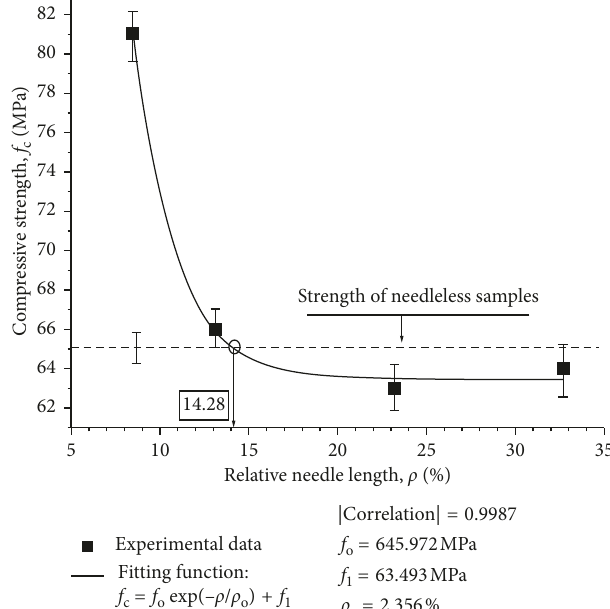
Figure 5: Compressive strength of hydrated ordinary Portland cement paste with embedded steel needles of various lengths.